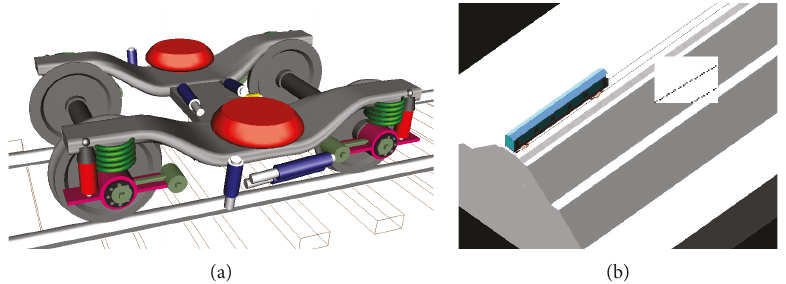
Figure 12: (a) Rail-bogie model (axis view). (b) Vehicle-track-subgrade coupling system model (axis view).